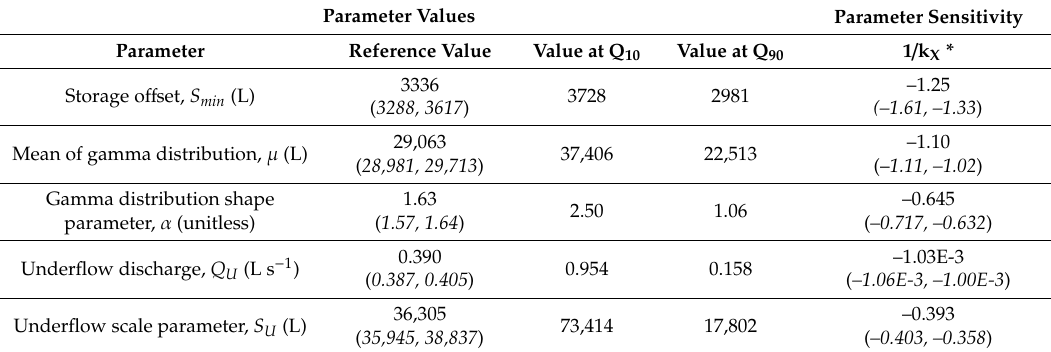
Table 3. Maximum likelihood parameter values from DREAM parameter estimation. Values in parentheses show the 10–90th percentile ranges. Columns show the value at median discharge,